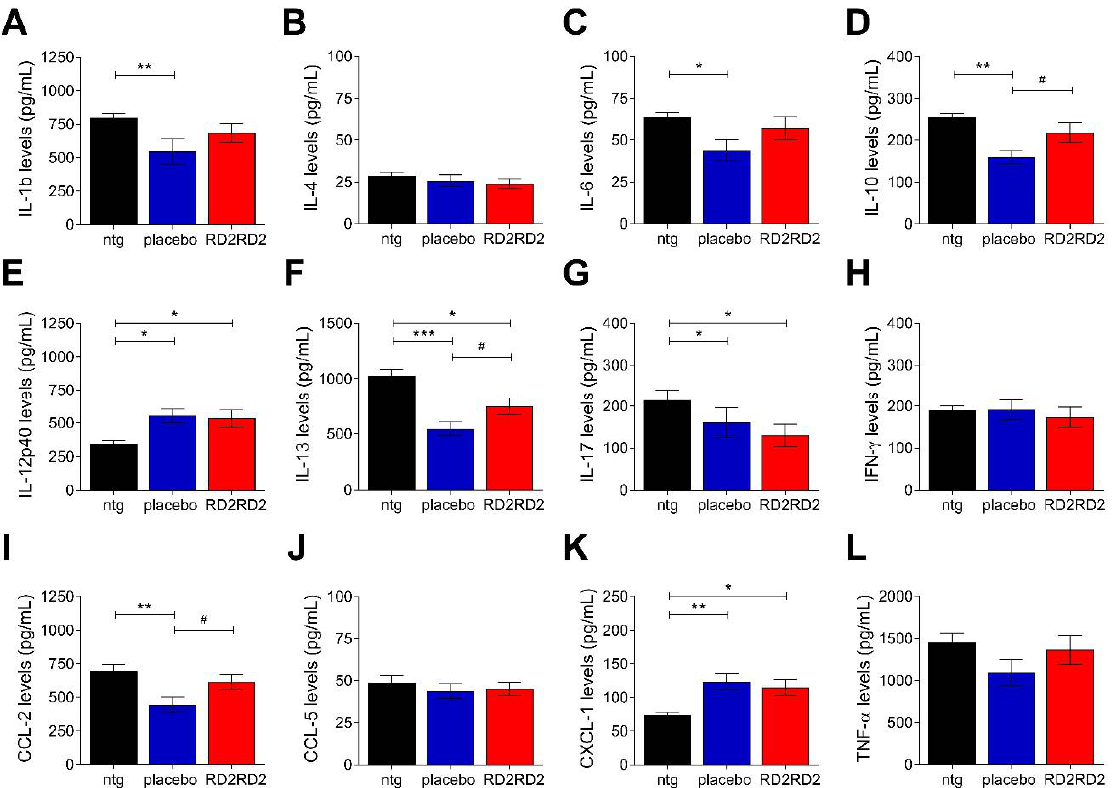
Figure 5. Treatment with RD2RD2 led to differences in several cytokine levels vs. non-transgenic and placebo-treated SOD1 G93A mice. A multiplex immunoassay was used to analyse a possible change of inflammatory cytokines at the end of the study. Cytokine concentrations are given in picogram per millilitre (pg/mL). Data is represented as mean ± SEM. Statistical calculations were conducted by one-way ANOVA with Fisher’s LSD post hoc analysis ( A – L ), ntg n = 7, placebo n = 11 and RD2RD2 n = 11. Asterisks (*) indicate significance between non-transgenic and transgenic treatment groups (ntg vs. placebo and ntg vs. RD2RD2: * p = 0.05, ** p = 0.01 and *** p < 0.001). Lozenges ( # ) indicate significance between transgenic treatment groups (placebo vs. RD2RD2: # p = 0.05).